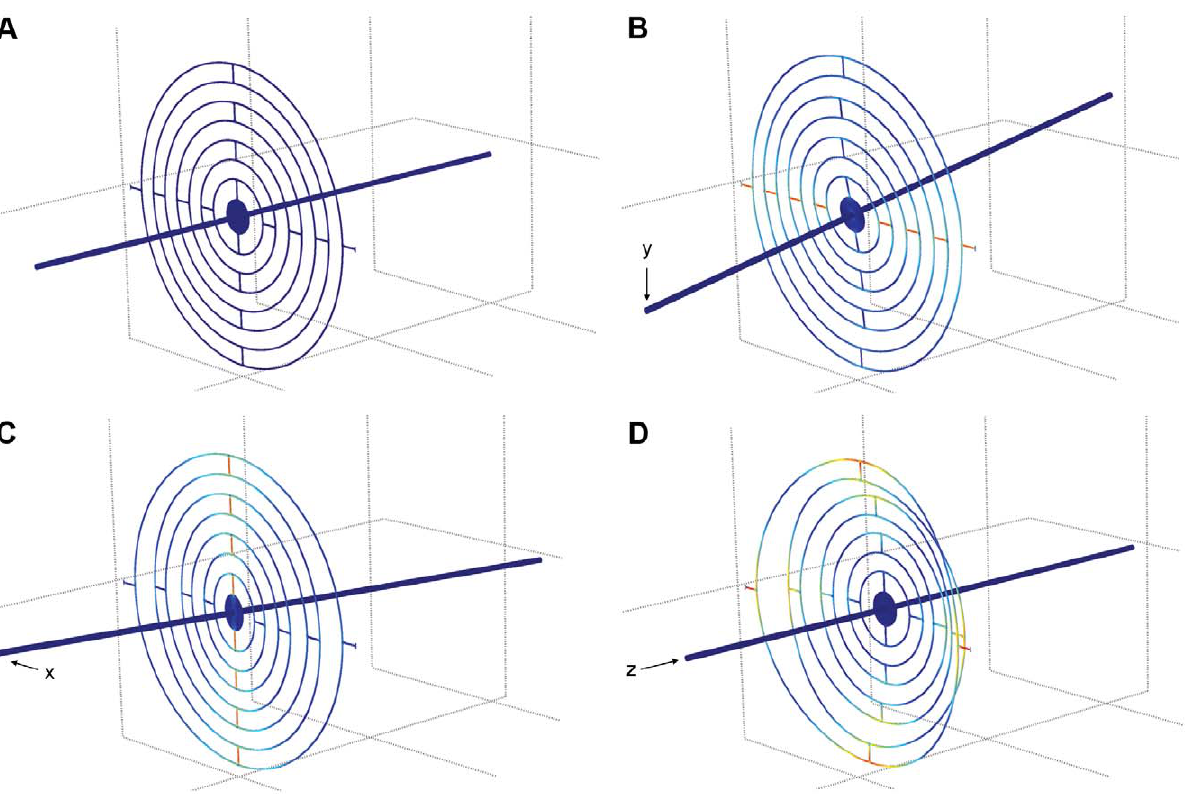
Figure 8. FEM simulations of the concentric arc sensor design. A, Simulated design in rest. B, Simulation of the probe tip movement along y- axis. C, Simulation of the probe tip movement along x-axis. D, Simulation of the probe tip movement along z-axis. Colors illustrate the strain of the metal film.